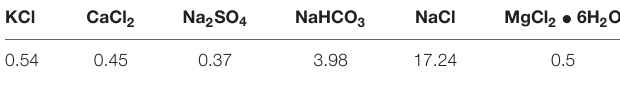
TABLE 1 | Chemical composition of artificial formation water (g L − 1